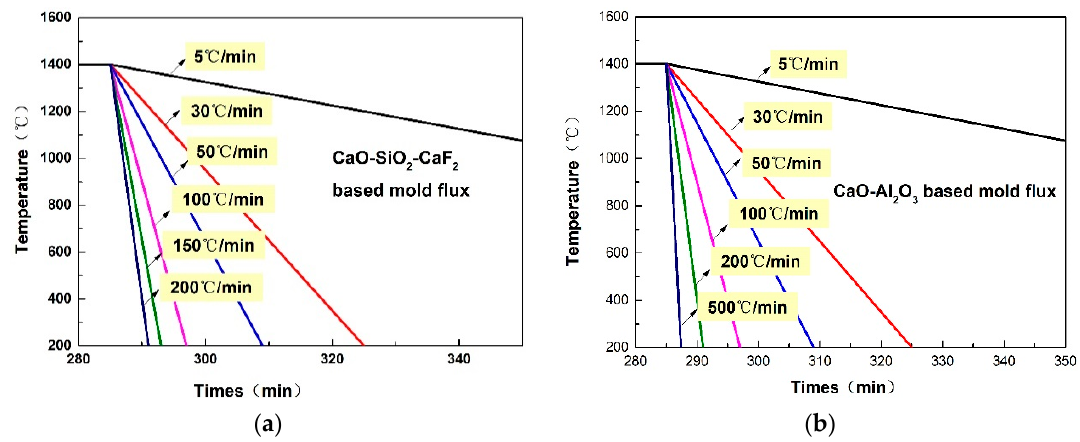
Figure 2. A diagram of the cooling process at different cooling rates in ( a ) a CaO–SiO 2 –CaF 2 -based mold flux and ( b ) a CaO–Al 2 O 3 -based mold flux.